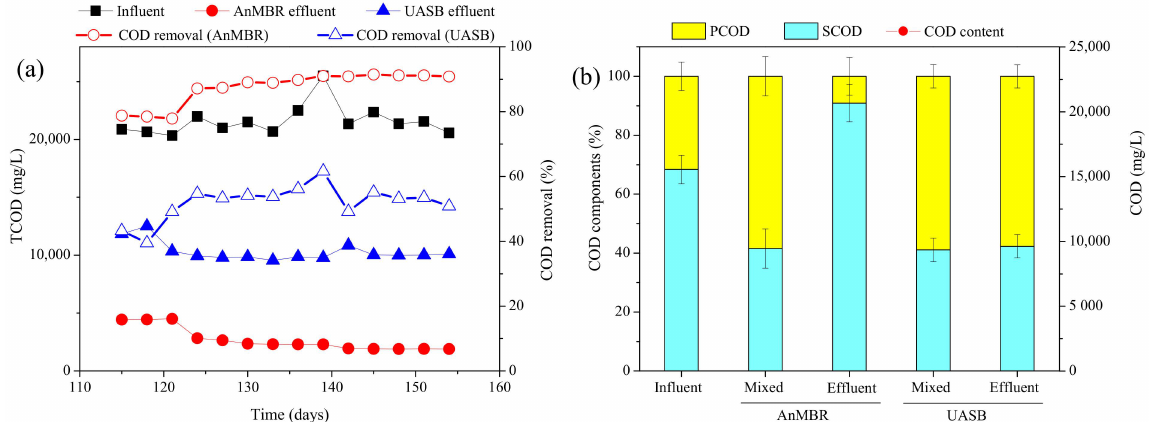
Figure 2. Variations of COD removal in AnMBR and UASB. ( a ) COD content; ( b ) COD components along the reactor. PCOD and SCOD represent particulate and soluble COD,